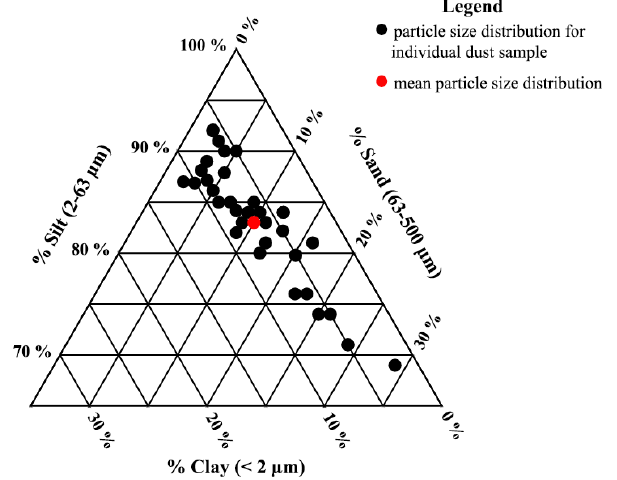
Figure 5. Ternary diagram showing volume distributions for 37 dust samples analyzed with the Malvern Mastersizer 3000. Silt is the most prevalent size class in the samples with a minimum ∼ 69% and maximum ∼